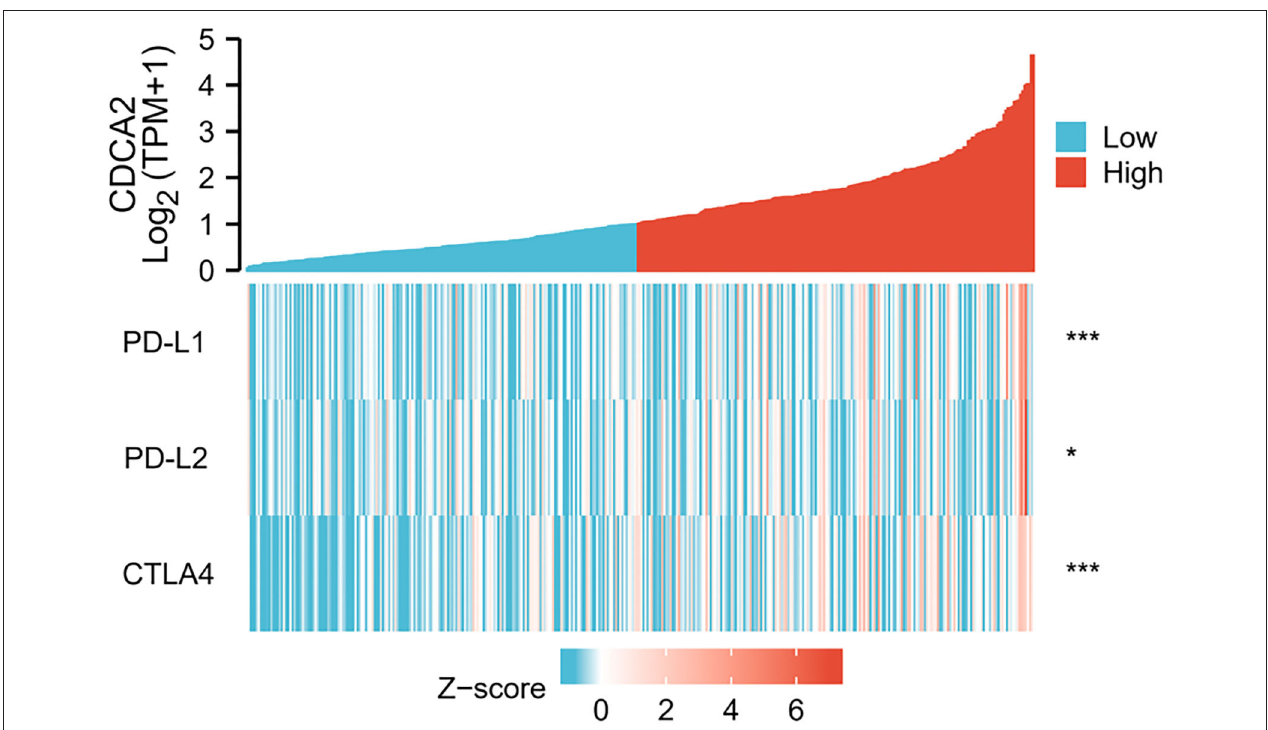
FIGURE 3 | Correlation of CDCA2 with expression level of immune checkpoints. (* p < 0.05; *** p < 0.001).